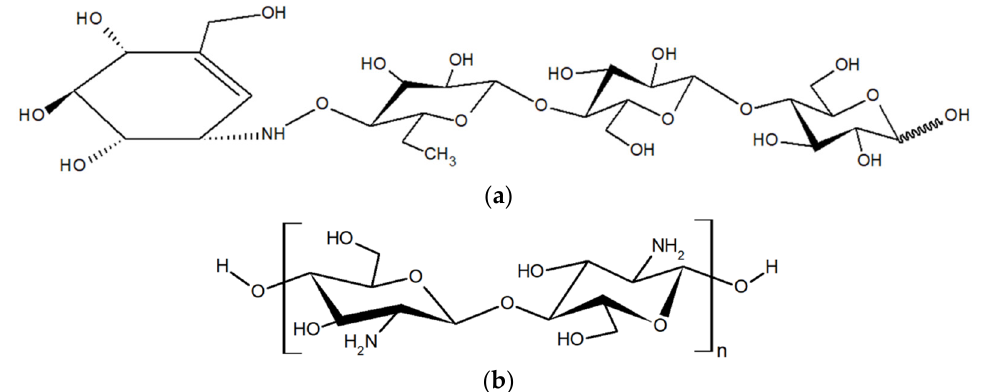
Figure 1. Chemical structure of acarbose ( a ) and chitosan oligosaccharide (COS) ( b ). Chitosan oligosaccharides (COS) are degraded by depolymerization from chitin or